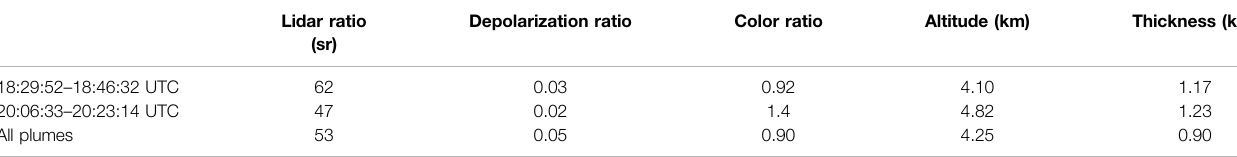
TABLE 2 | Summary of smoke plume characteristics from the Williams Flats Fire fl own on 8 August 2019. Median values of Williams Flats Fire plume